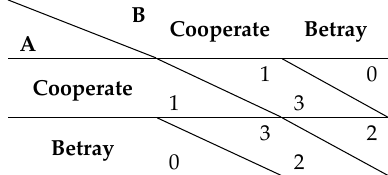
Table 1. The prisoner’s dilemma with the actions of Agent A and B with the resulting time in prison.